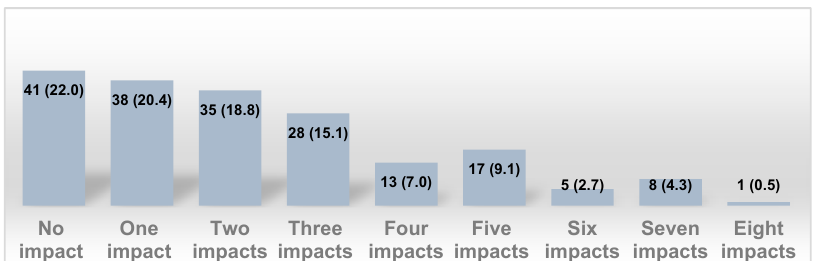
Figure 1. Frequency distribution and percentages (F [%]) of number of impact performance experienced among children in Madinah, Saudi Arabia (SA) ( n = 186).